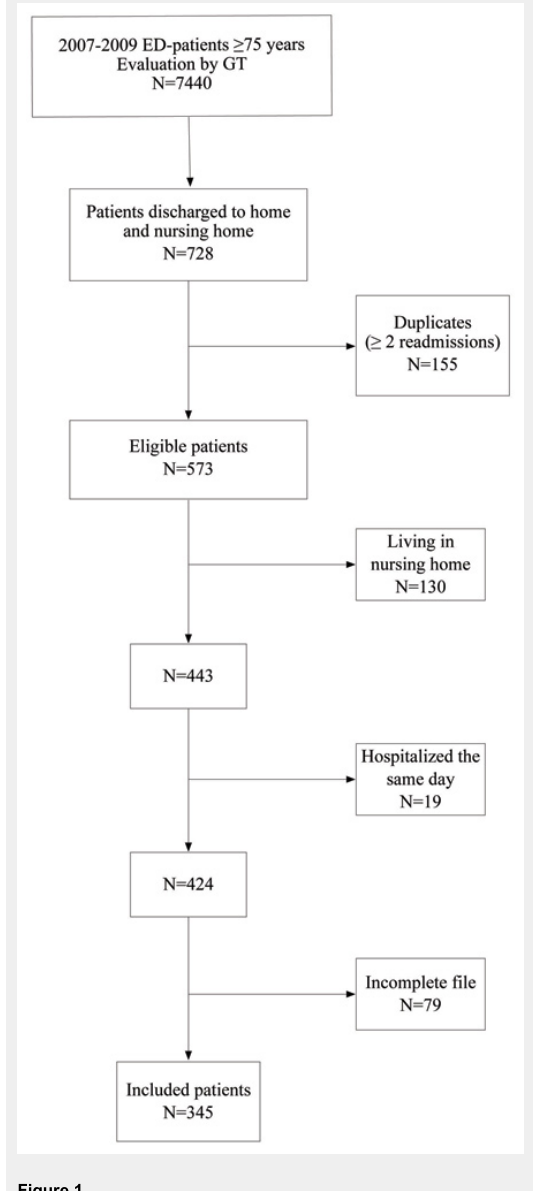
Figure 1 Flow diagram of the studied population. ED: Emergency Department. GT: Geriatric